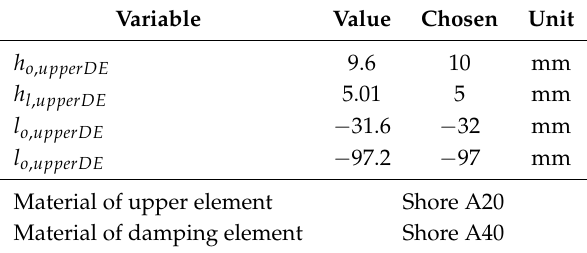
Figure 10. Pareto-front of the optimization referring the maximum deflections arising due to the specified unbalances of 20 gmm. Table 3. Optimized Variables.